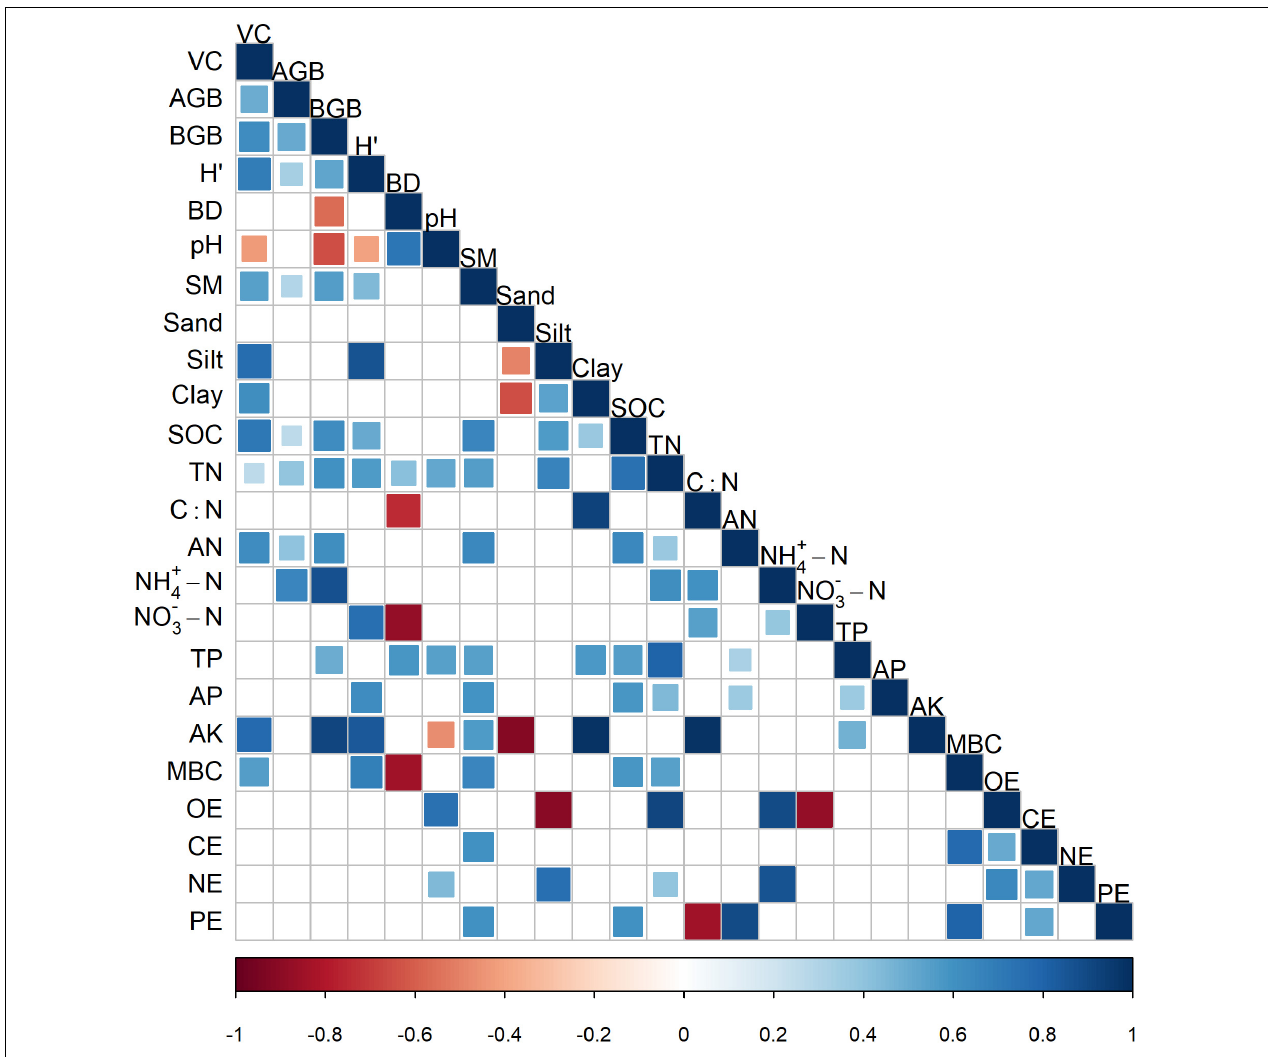
FIGURE 5 | Relationships of the effect sizes of each variable with others. Square size and colors represent Pearson correlations. Only significant results with a sufficient sample size ( n > 4) were